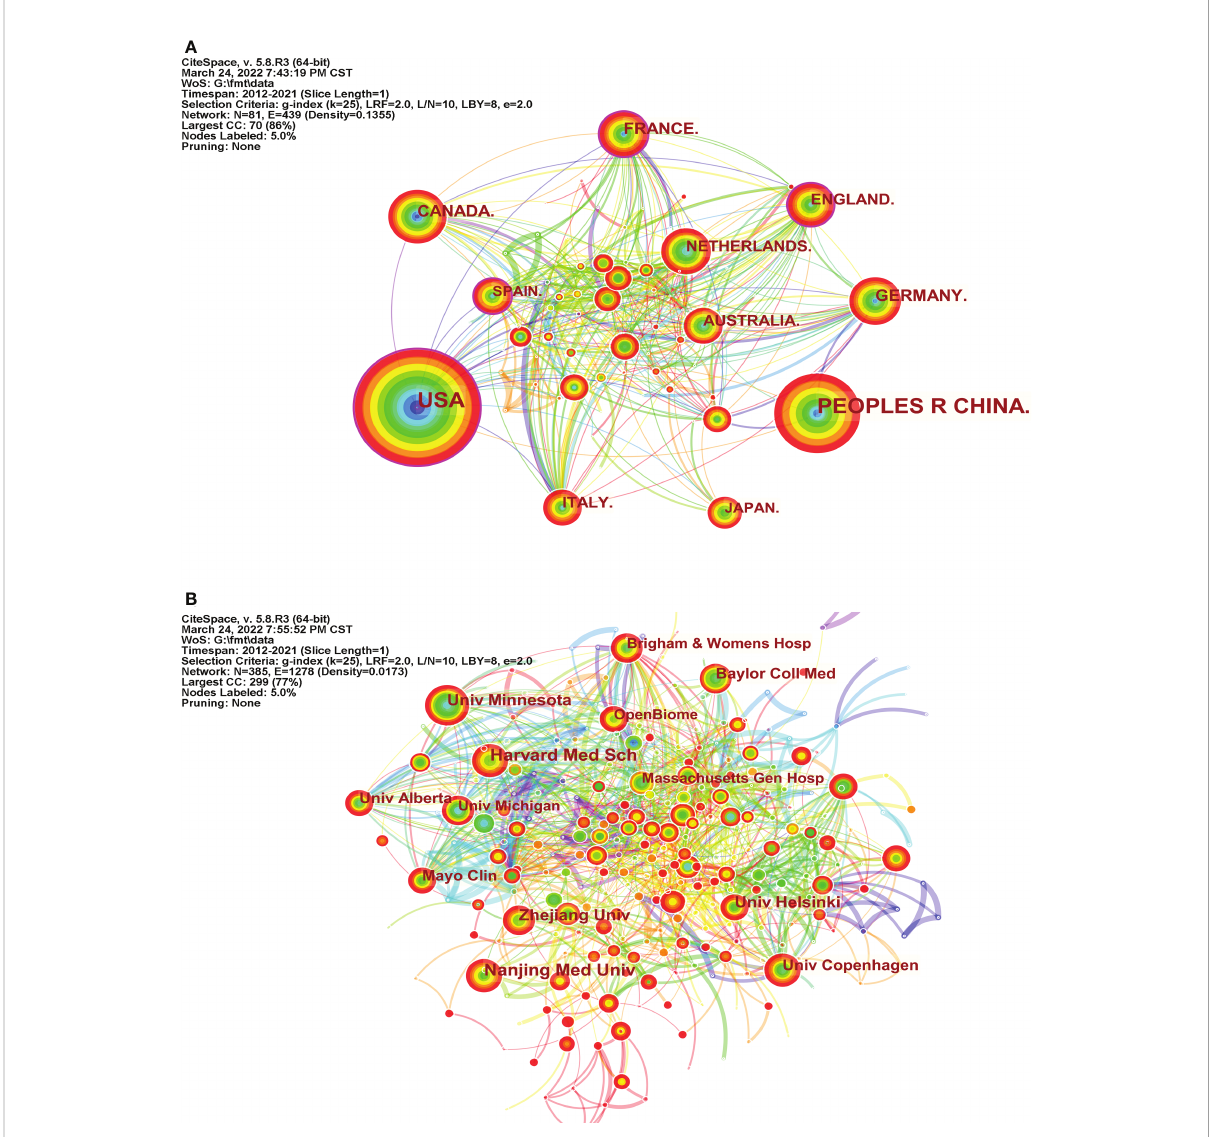
FIGURE 2 Countries and Institutions Analysis. (A) Map of countries performing FMT-related research (N=81, E=439); (B) Map of institutes performing FMT- related research (N=385,